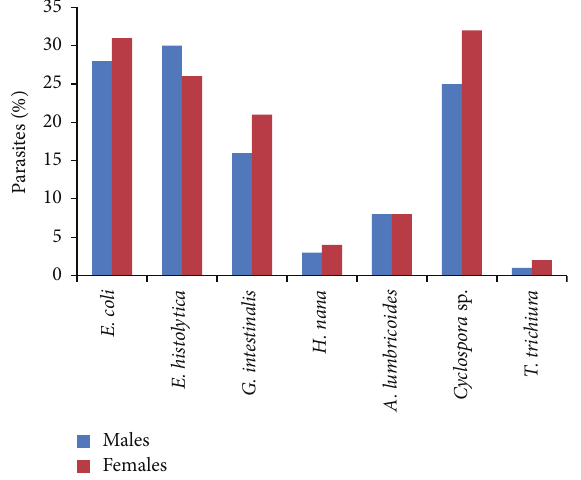
Figure 3: Distribution of parasites among males and females of low socioeconomic areas.